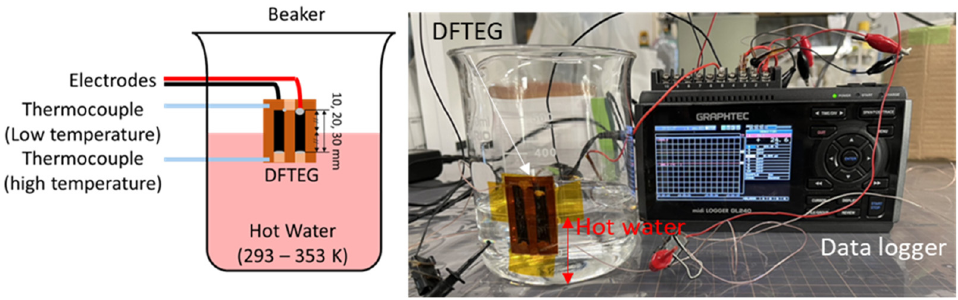
Figure 3. Measurement system for the thermoelectric performance of